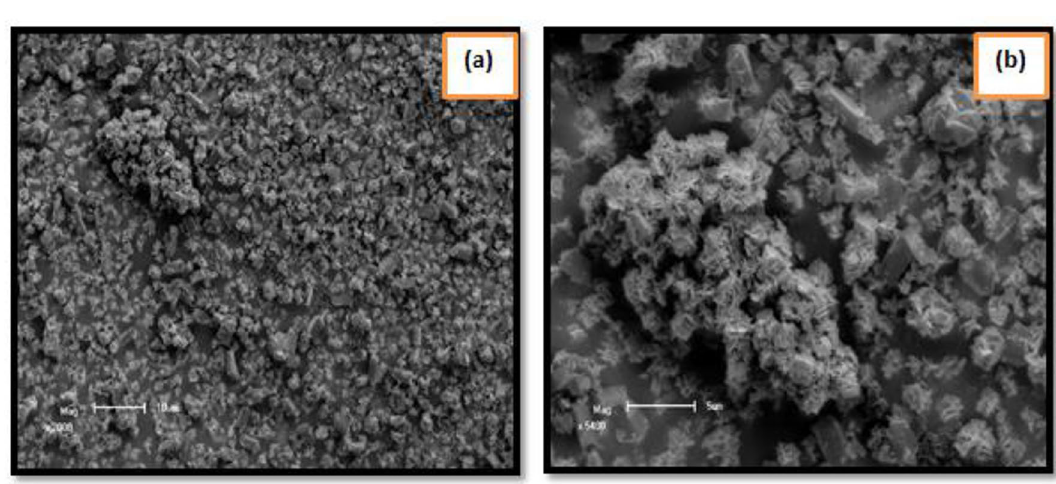
Figure 5. Scanning electron microscope (SEM) images of TiO 2 nanoparticles from Carica papaya shell